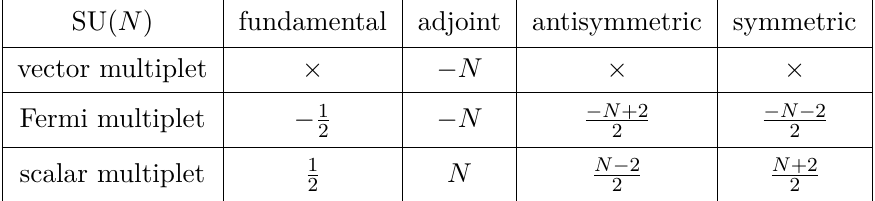
Table 5 . Anomaly contributions of the 2 d N = (0 , 1) multiplets in various representations of SU( N ) . Since anomalies are quadratic in 2d, the same contributions apply for the conjugate repre-